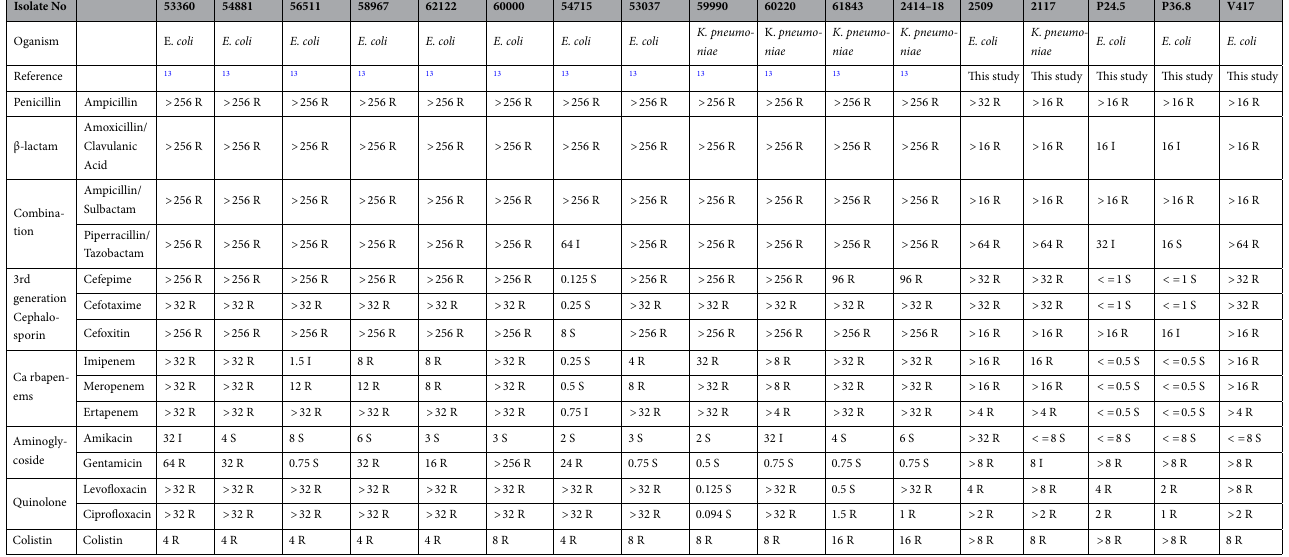
Table 2. Antimicrobial susceptibility of mcr-1 -harboring carbapenem-resistant E. coli and K. pneumoniae